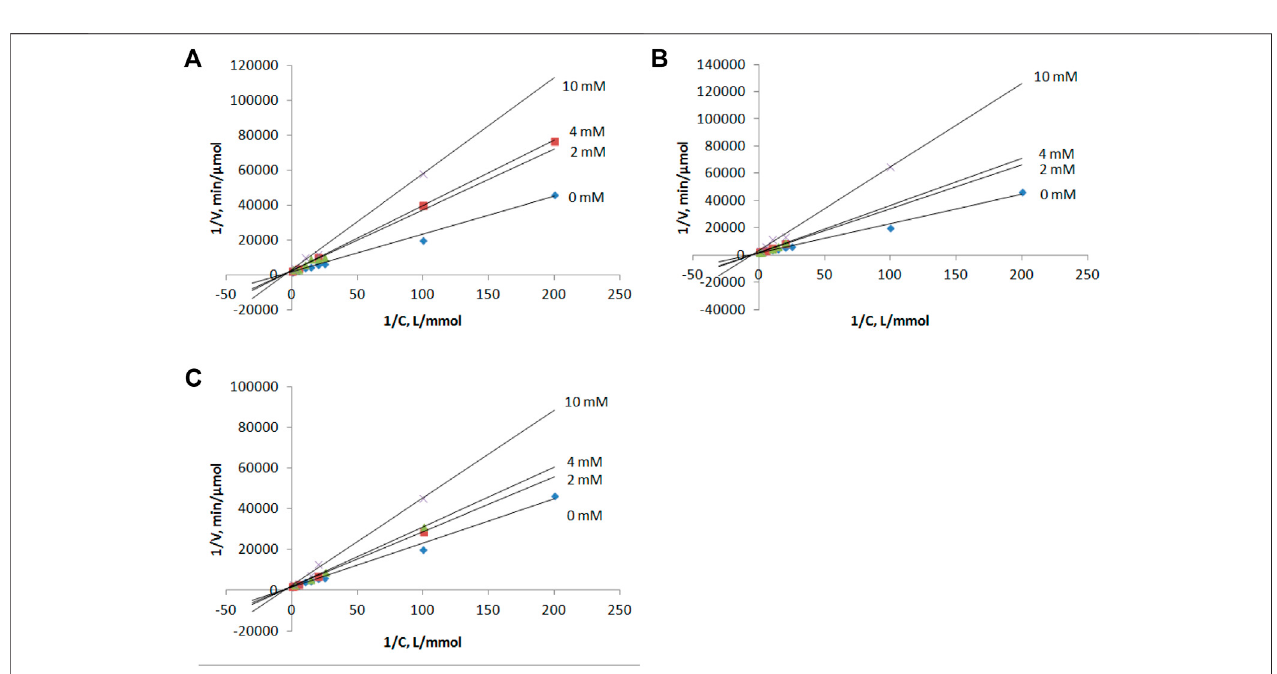
FIGURE 3 | Lineweaver – Burk plots for the inosine phosphorolysis at concentrations of compounds 1 , 2 and 3 equal to 0, 2, 4 and 10 mM. (A) compound 1 , (B) compound 2 , (C) compound 3 .